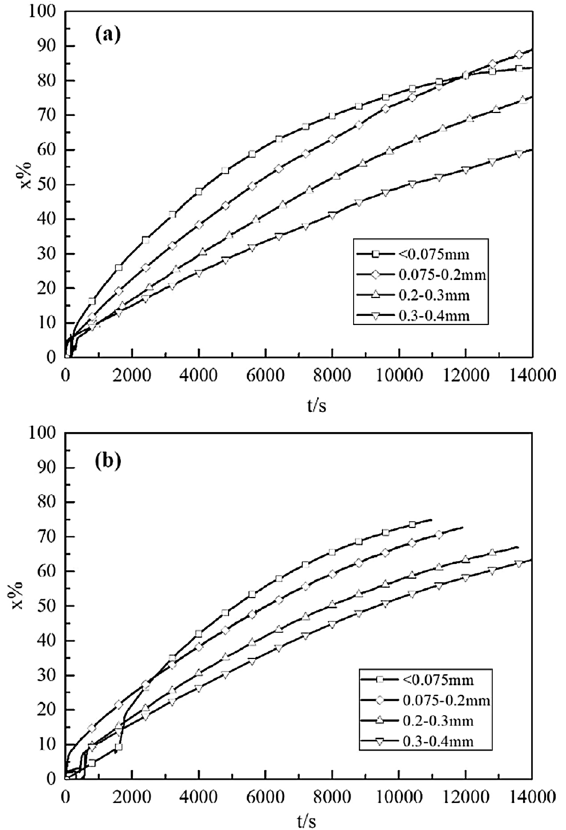
Fig. 3 Variation of carbon conversion with time at different particle size in a raw coke samples and b samples adsorbed Na 2 CO 3